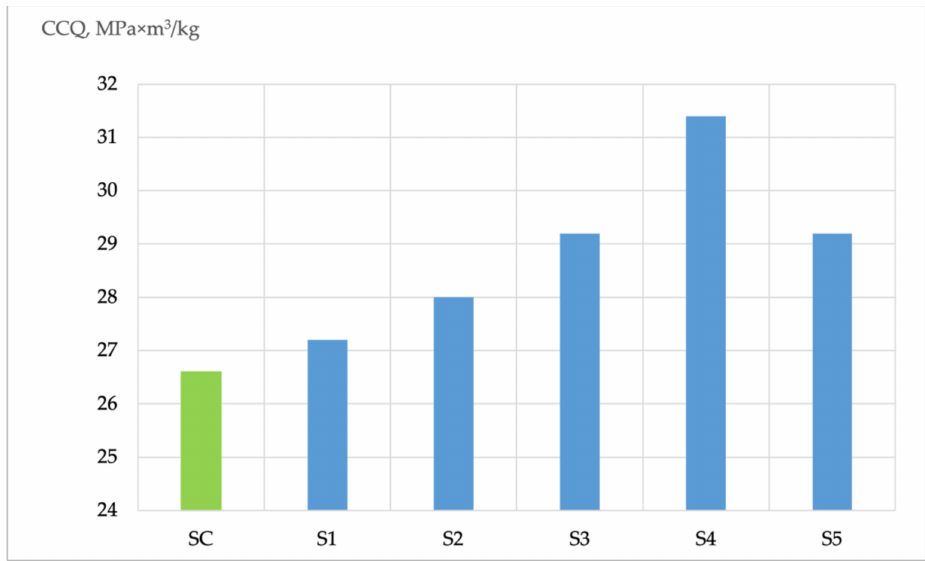
Figure 7. Diagram of CCQ for the volume ratio of porous and dense aggregates. SC—the control composition of concrete (without slag pumice); S1–S5—compositions by Table